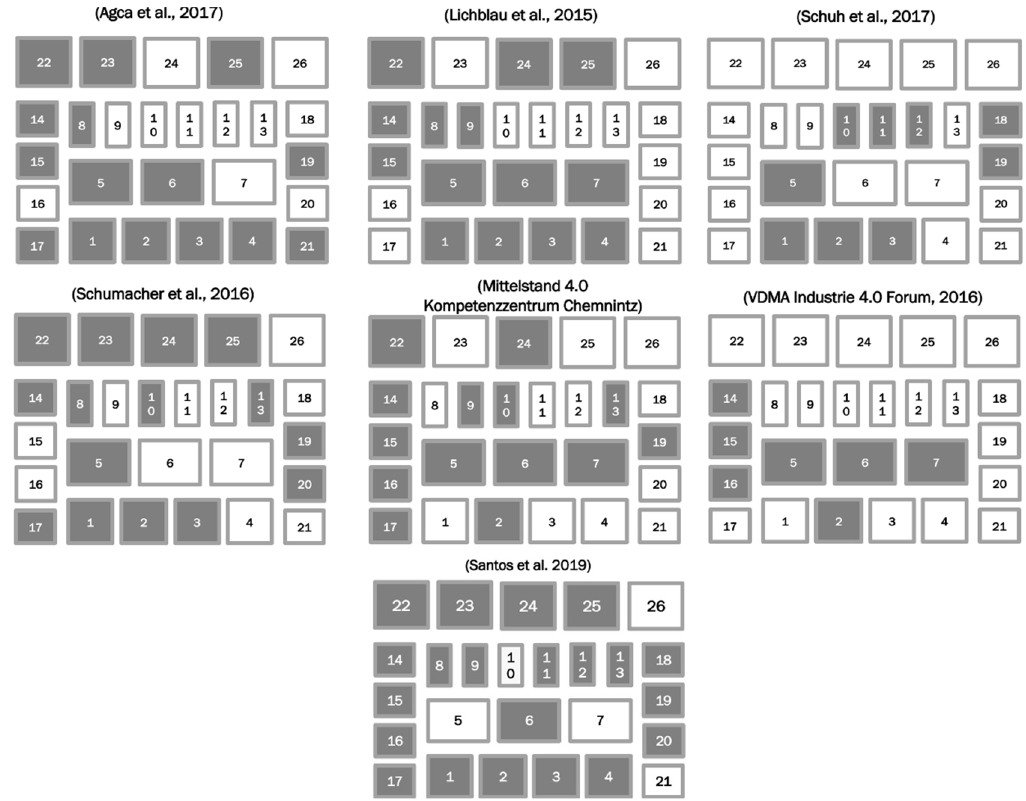
Figure 3. Pictographic comparison of proposed framework’s dimensions and base model.